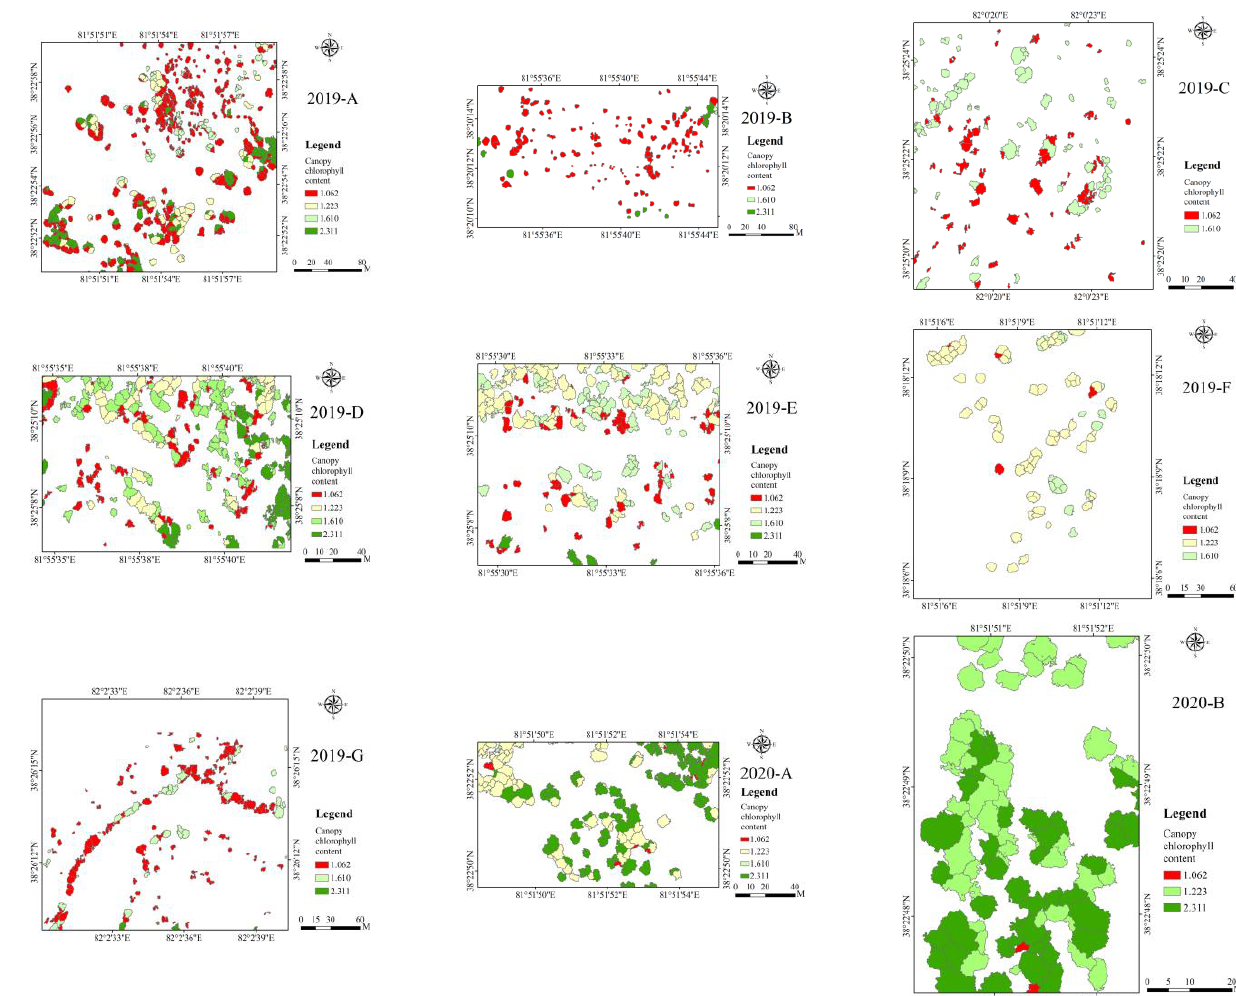
Figure 13. Inversion map of chlorophyll content in PeITC for each quadrat.